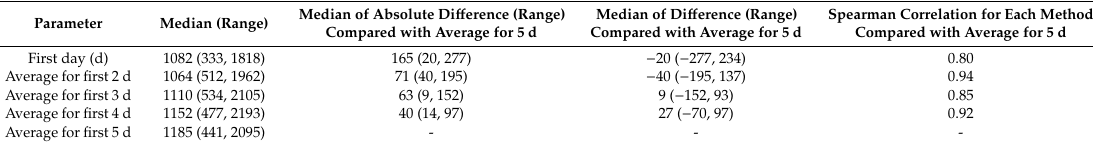
Table 2. Average values for leg movement rate.